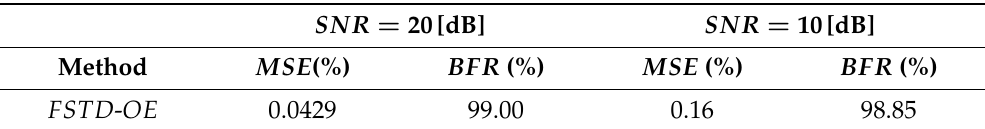
Table 2. BFR and MSE obtained by the FSTD - OE algorithm ( nmc = 200runs, SNR y = 20, and10[dB]): example 1.